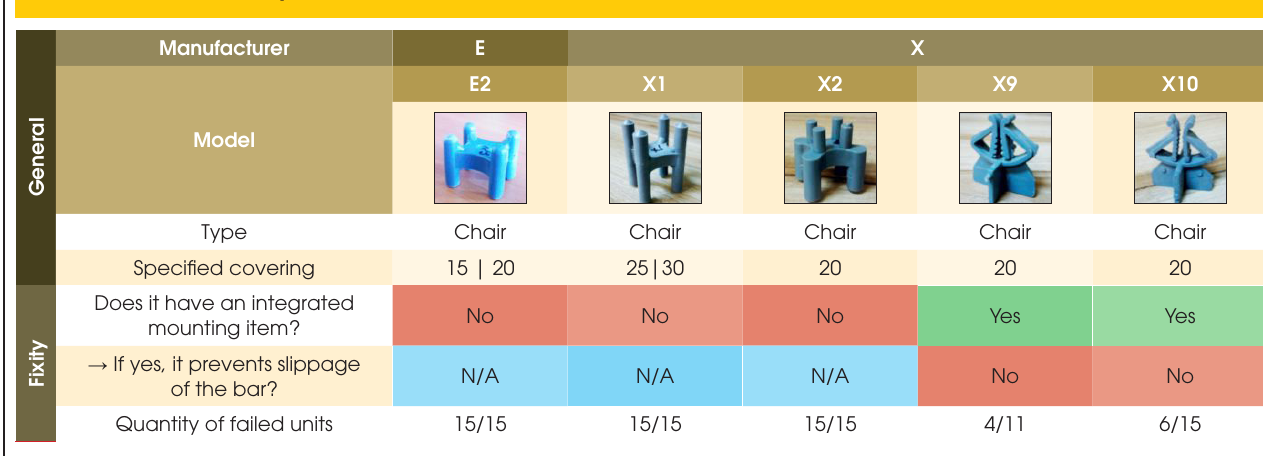
Table 9 – Results of the fixity requirement evaluation of the chair-type